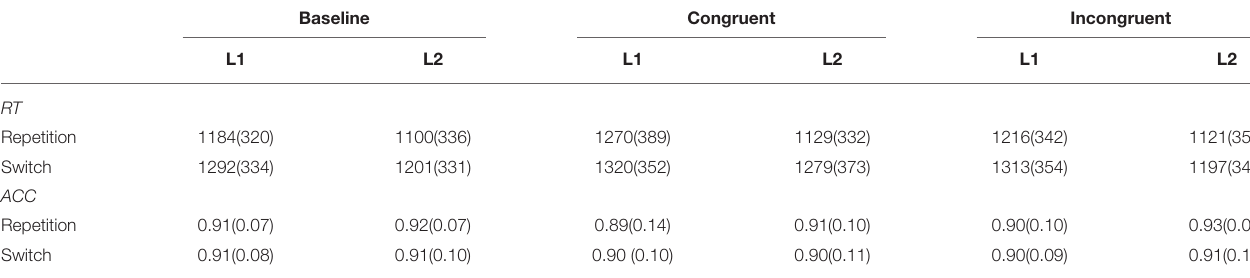
TABLE 3 | Mean RTs and Accuracy for all three contexts (standard deviations in parentheses).